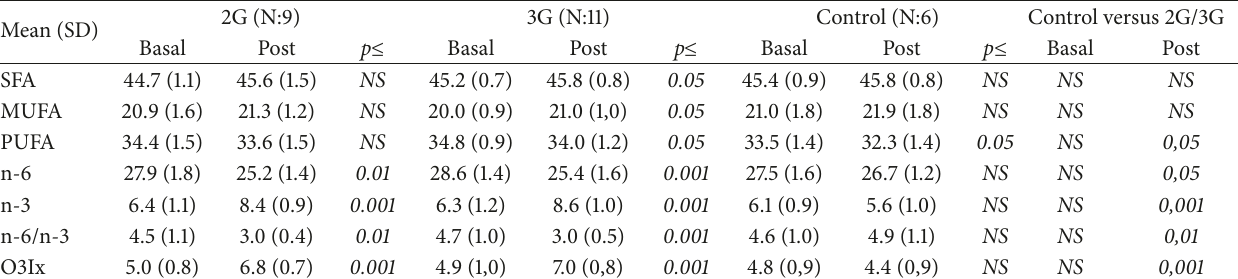
Table 2: Erythrocyte fatty acids profile of the participants as a function of the dose through the study.